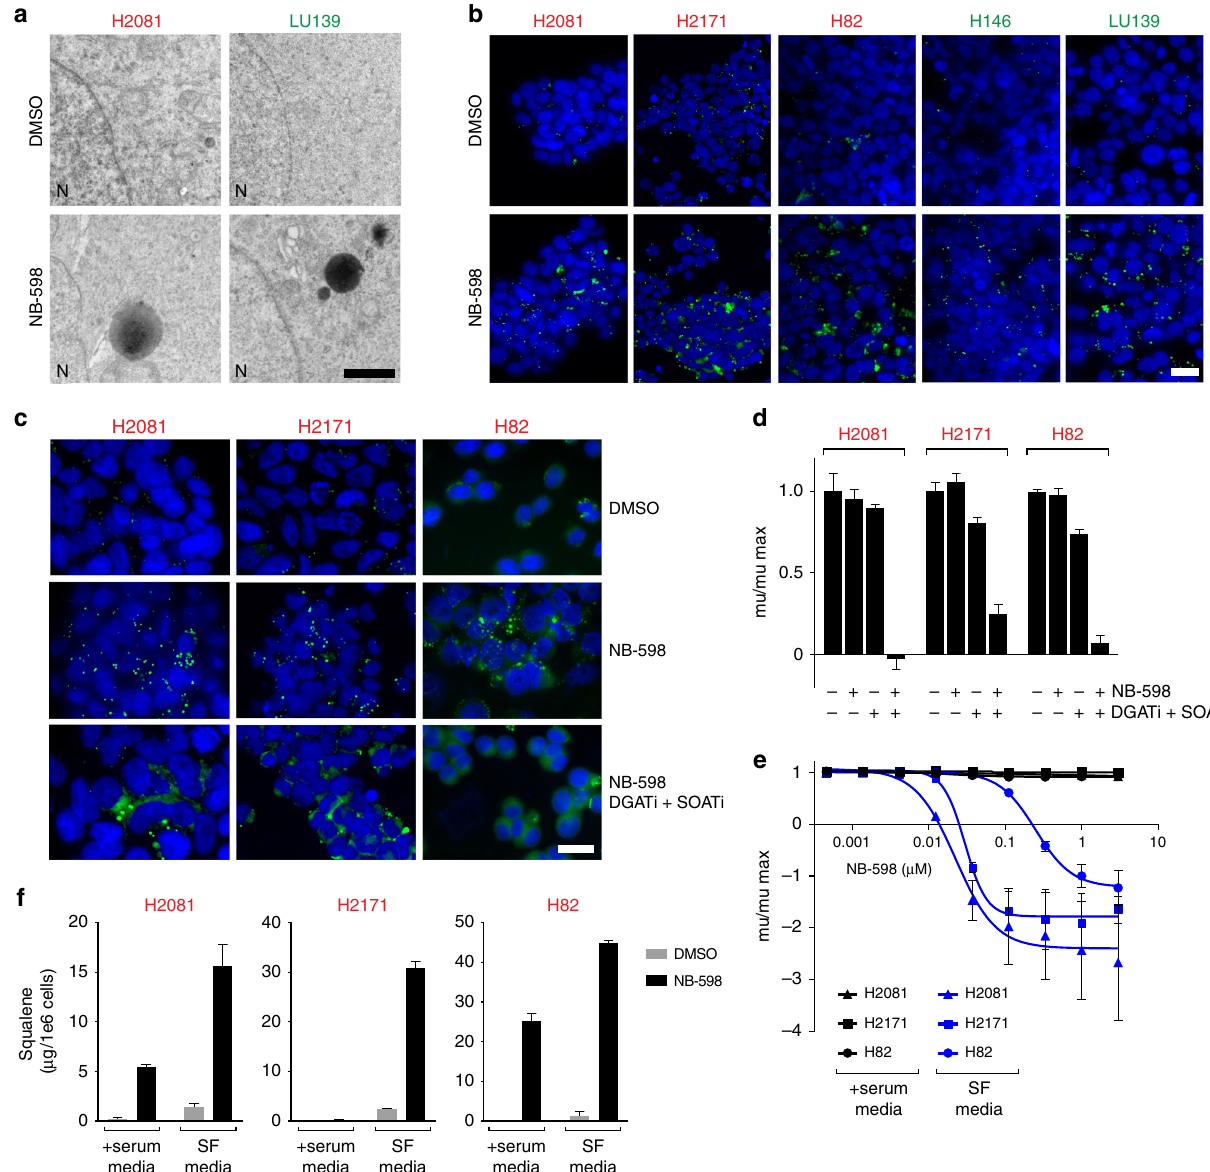
Fig. 6 Lipid droplets and squalene storage. a Transmission electron microscopic image of darkly staining droplets. LU139 and H2081 cells were treated with 1 μ M NB-598 for 48 h. Scale bar represents 1 μ m. b BODIPY neutral lipid stain identi fi es lipid droplets in multiple cell lines. Cells were treated with 1 μ M NB- 598 for 24 h. Scale bar represents 20 μ m. c Inhibition of DGAT and SOAT enzymes abrogates the formation of NB-598-induced lipid droplets. Cells were treated for with 1 μ M NB-598. AZD-3988 was used as the DGAT inhibitor (10 μ M for H2081 and H2171 cell lines; 7.5 μ M for H82 cell line). F12511 was used as the SOAT inhibitor (10 μ M for H2081 and H2171 cell lines; 7.5 μ M for H82 cell line). Treatment duration was 24 h. Scale bar represents 20 μ m. d Relative NB-598 sensitivity of SQLE-insensitive cell lines after abrogation of lipid droplet formation. Inhibitor concentrations used were identical to the ones used in the preceding panel. Treatment duration was 72 h. e Relative NB-598 sensitivity in a representative panel of SQLE-insensitive cell lines grown in two different media: serum-containing and serum-free (SF). f Squalene accumulation in cell pellets in a panel of SCLC cell lines after 1 μ M NB-598 treatment for 24 h. For d – f , mean values of triplicate measurements from a representative experiment are plotted and error bars represent